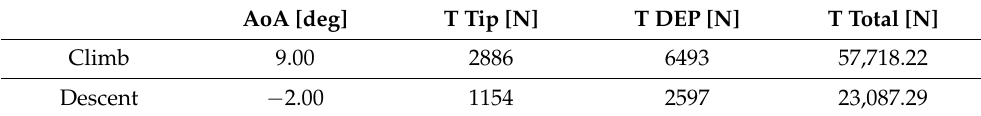
Table 3. Main characteristics—Mot. 2.